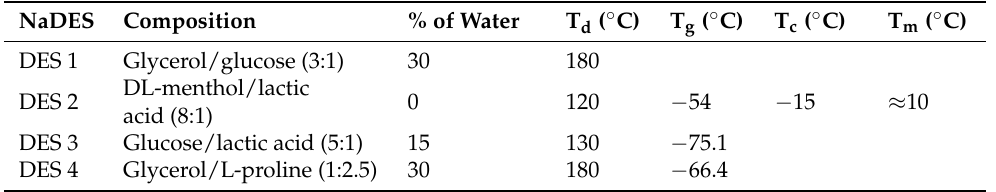
Table 4. Results of thermal analyses of NaDESs.